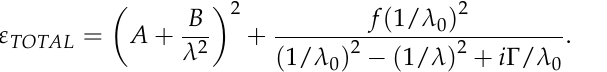
Figure 3. ( а ) Transmittance dynamics of WO 3 -based sensing element exposed to 200 ppm hydrogen in nitrogen. ( b ) Normalized transmittance for selected wavelengths (shown in Figure 3 а by arrows): initial position of the maximum (766 nm); the position of the maximum 1 h after the supply of hy- drogen (713 nm); left (600 nm) and right (900 nm) boundaries of the observation area. Response t ) are shown near the curves (in minutes). times retrieved from a single-exponential fit ( 1